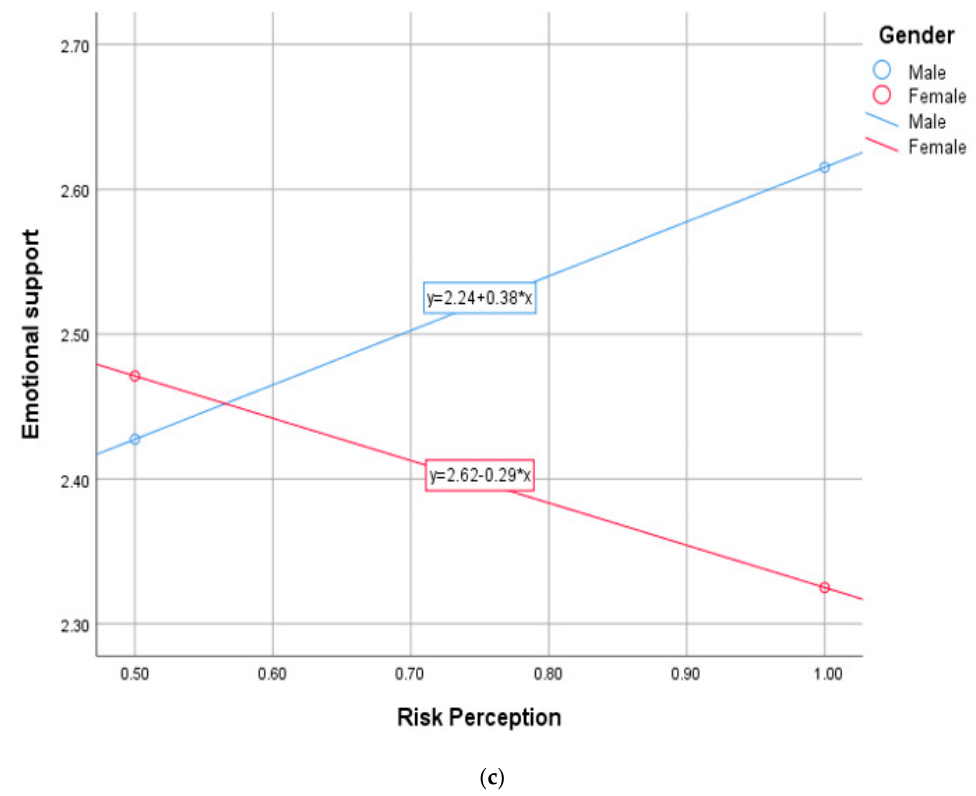
Figure 1. ( a ) Moderation effect of gender in the relationship between COVID-19 risk perception and active coping. ( b ) Moderation effect of gender in the relationship between COVID-19 risk perception and behaviour disengagement coping. ( c ) Moderation effect of gender in the relationship between COVID-19 risk perception and emotional support